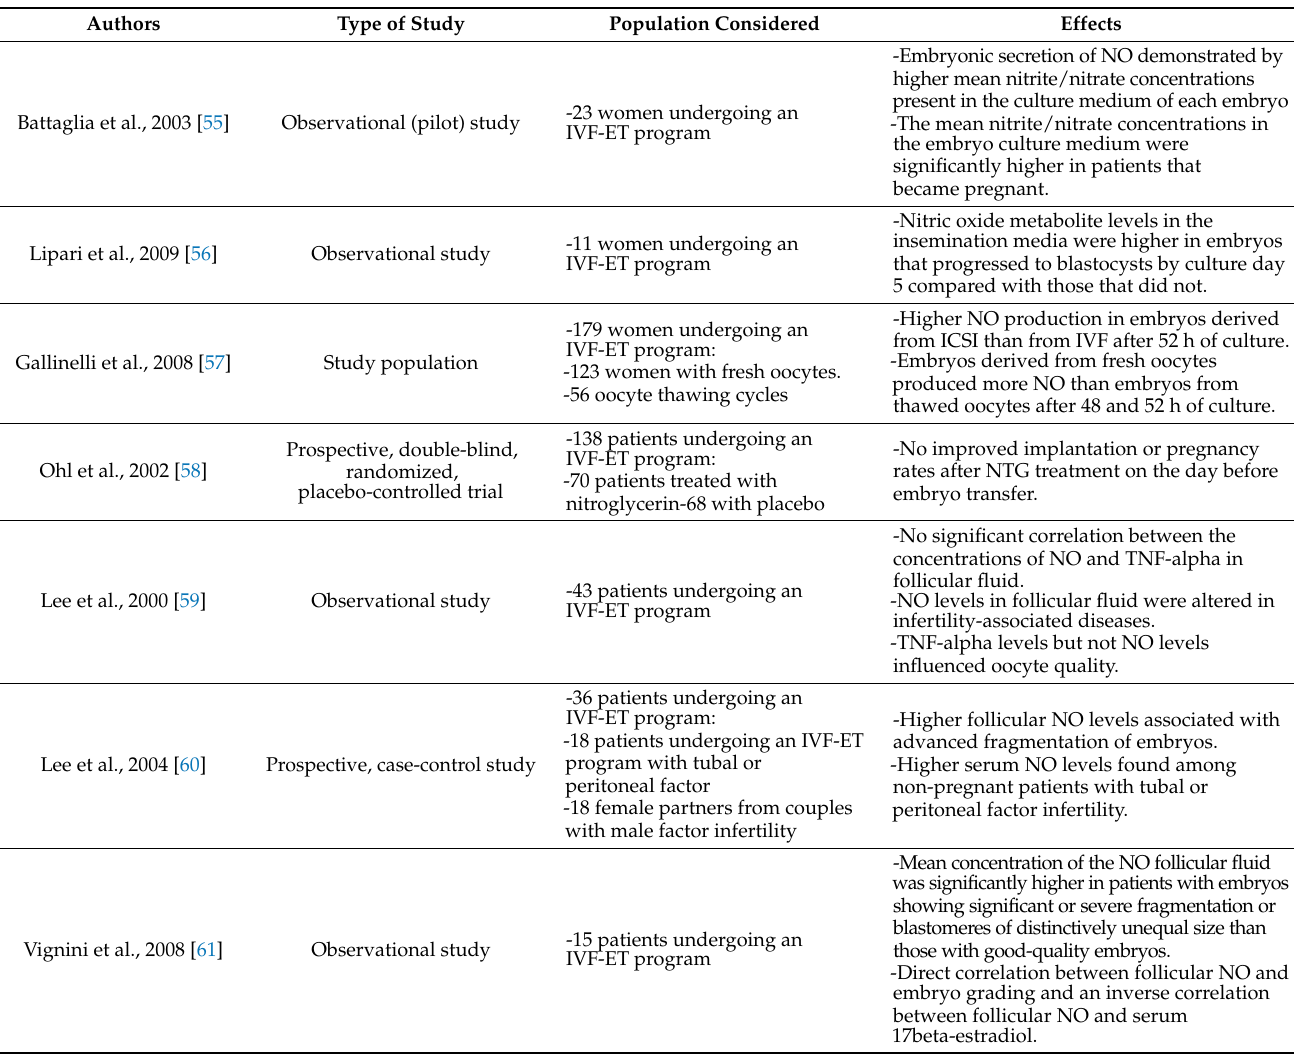
Table 5. Clinical studies investigating the role of NO in